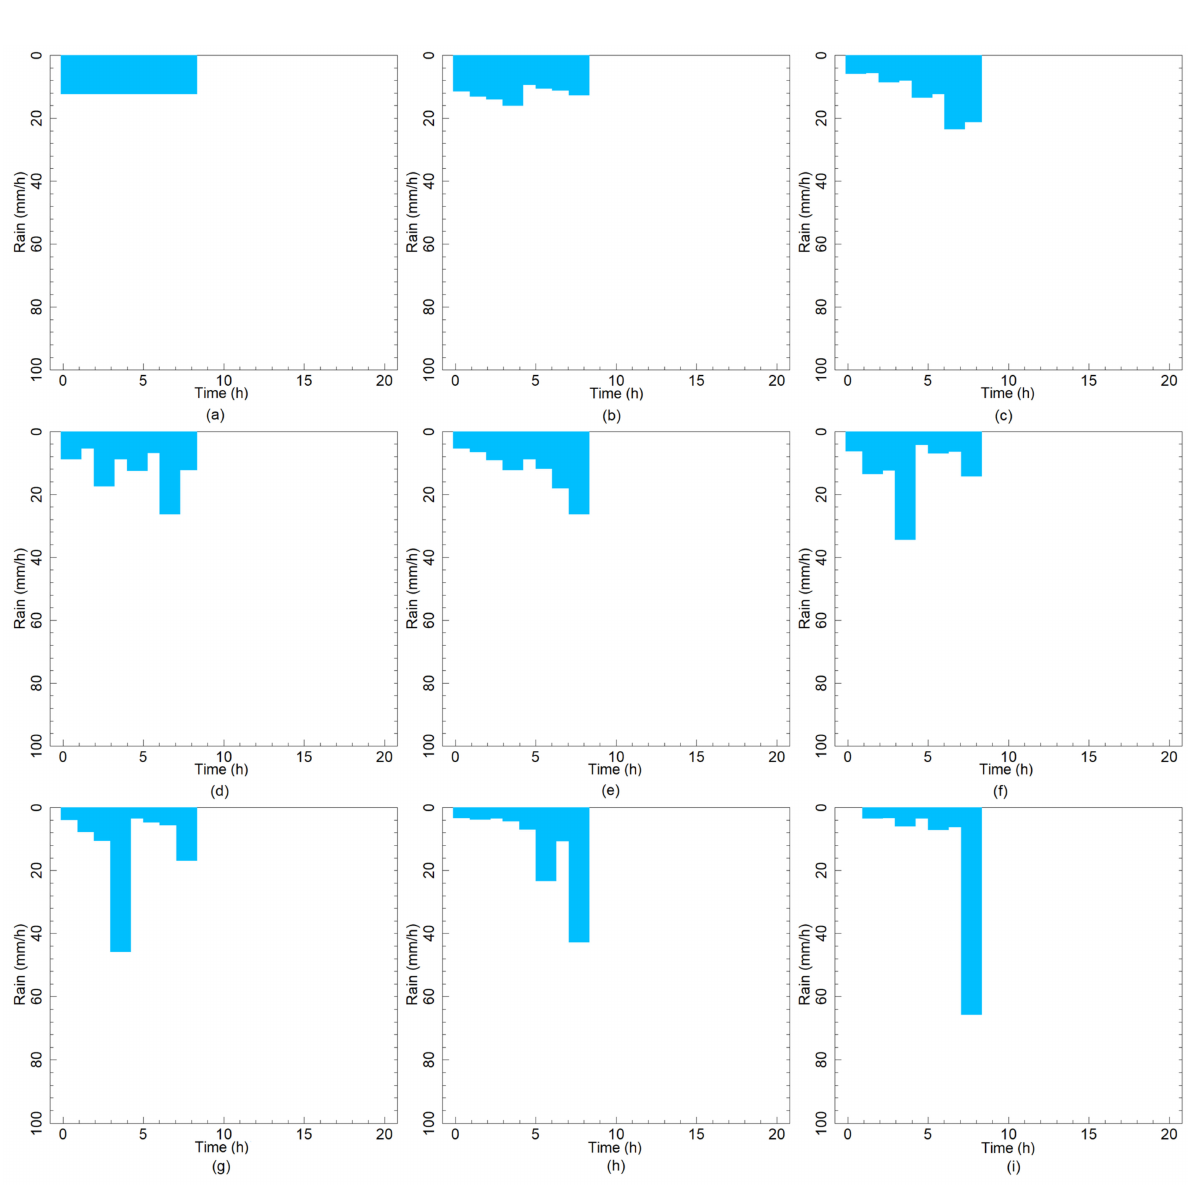
Figure 3. Nine of the generated synthetic rain signals illustrated as examples. Rain signals σ 2 = 0 ( a ), 4.55 ( b ), 48.67 ( c ), 49.04 ( d ), 50.34 ( e ), 99.22 ( f ), 214.50 ( g ), 208.76 ( h ), 496.41 ( i ) are